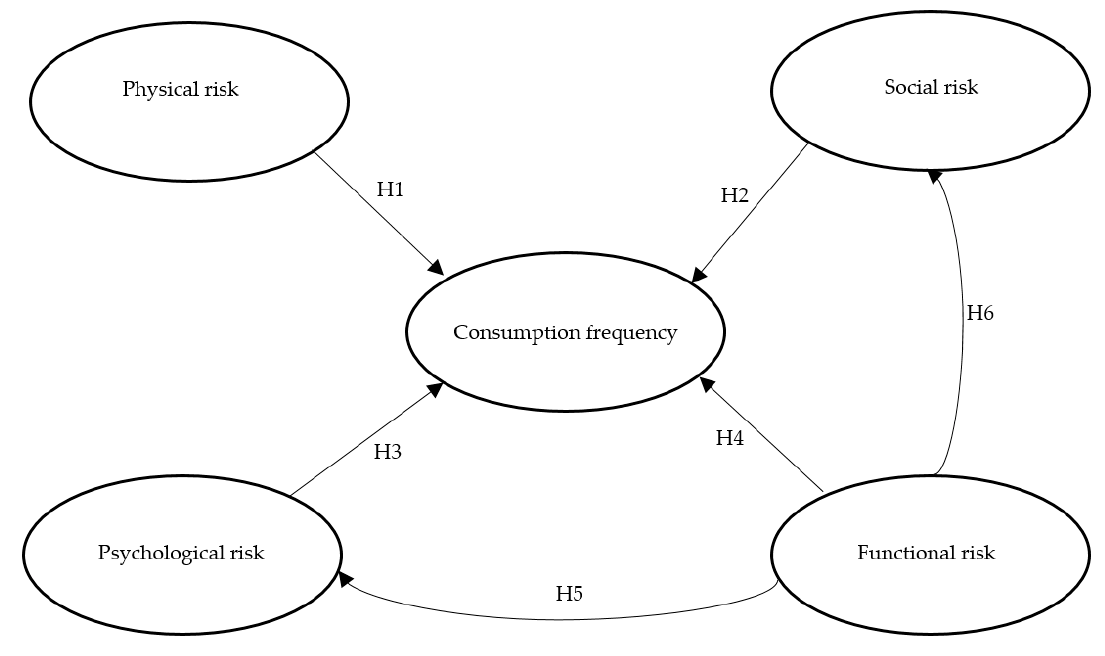
Figure 2. Conceptual framework.